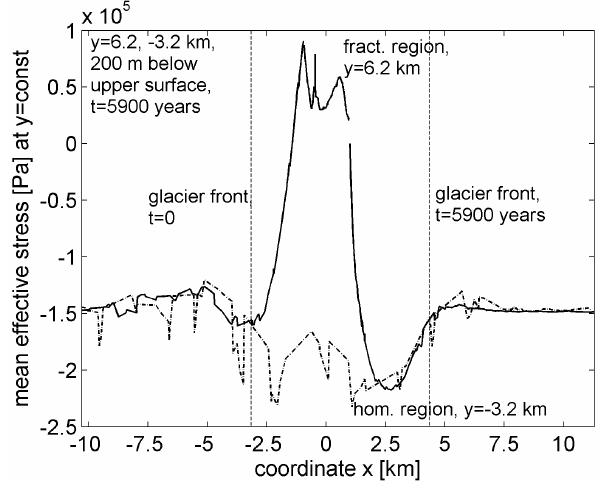
Figure 15. Variation of the mean effective stress [Pa] in the intact part of the rock mass with fracture zones in the cross sections of the fractured and homogeneous regions of the rock mass y = 6200 and − 3200m respectively, at a depth of 200m and at time 5900